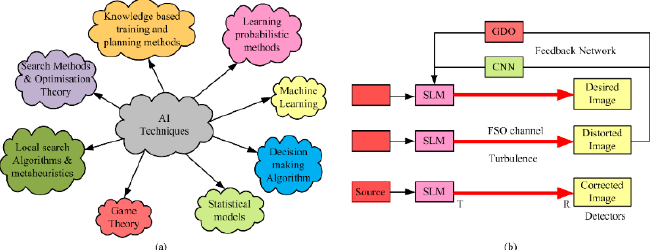
Figure 39. ( a ) AI design subfields and techniques, and ( b ) schematic of turbulence mitigation feed- back network with CNN and GDO .